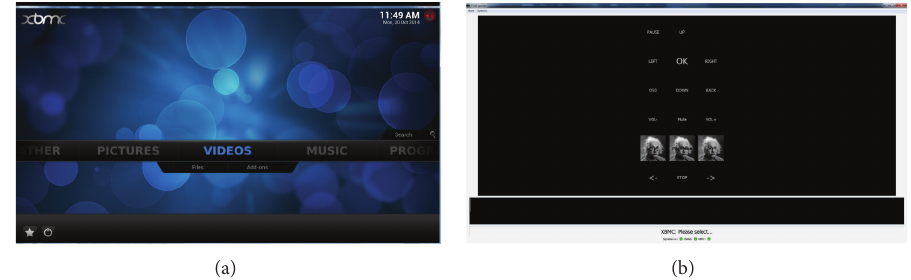
Figure 8: Screenshot of the XBMC application (a) and the P300 controller (b).